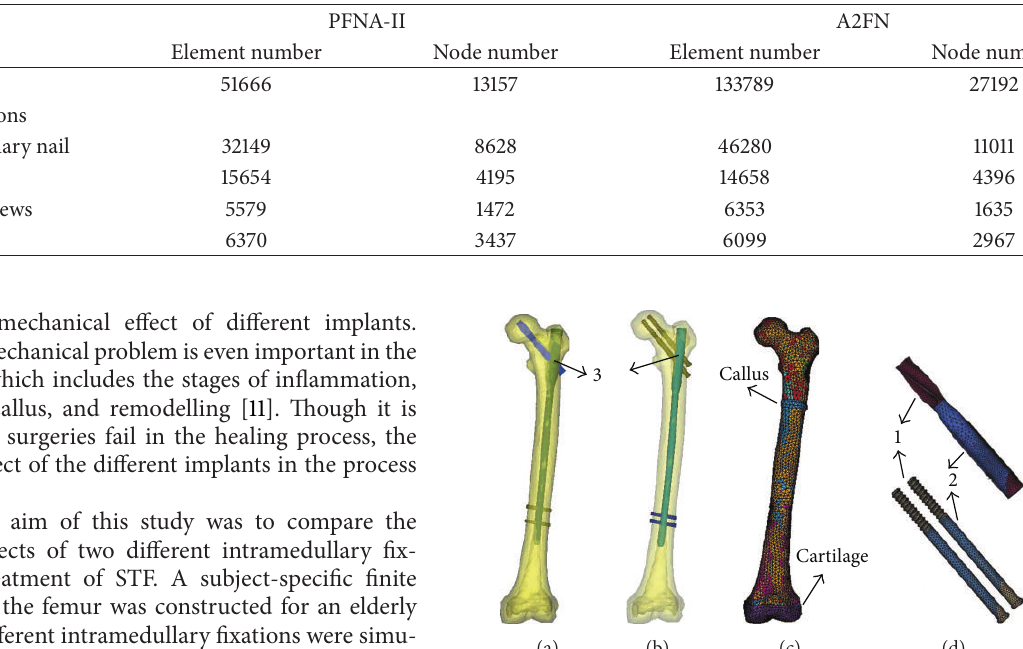
Table 1: Numbers of elements, nodes, and contact elements in the PFNA-II and A2FN models.